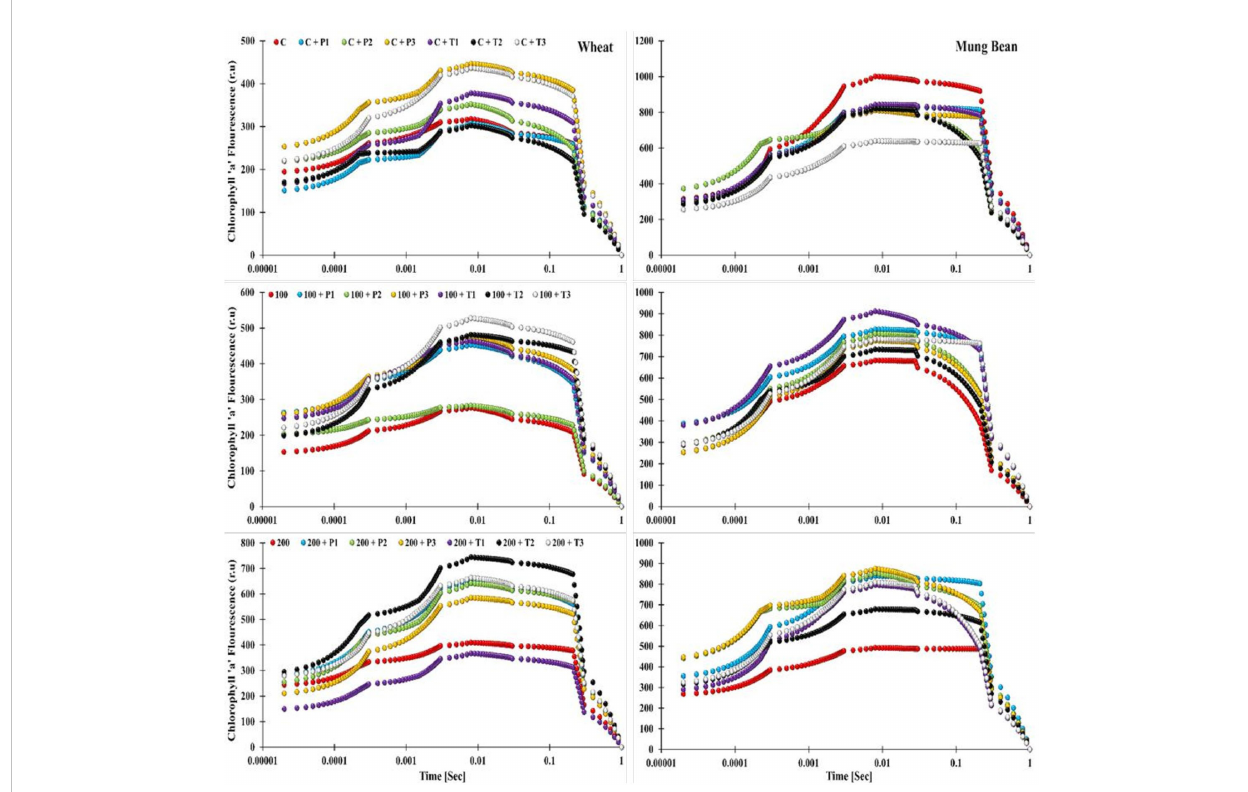
FIGURE 5 Effects of bio-priming with fungal endophytes on OJIP transient curve of wheat and mung bean grown under saline environment. The symbols on the horizontal axis represents: Control: Seeds without priming, Pl = Seed priming with Paecilomyces lilacinus , Th= Seed priming with Trichoderma hamatum 5, 10, 15 = duration of bio-priming in minute, 0, 100 & 200 mM NaCl concentration.